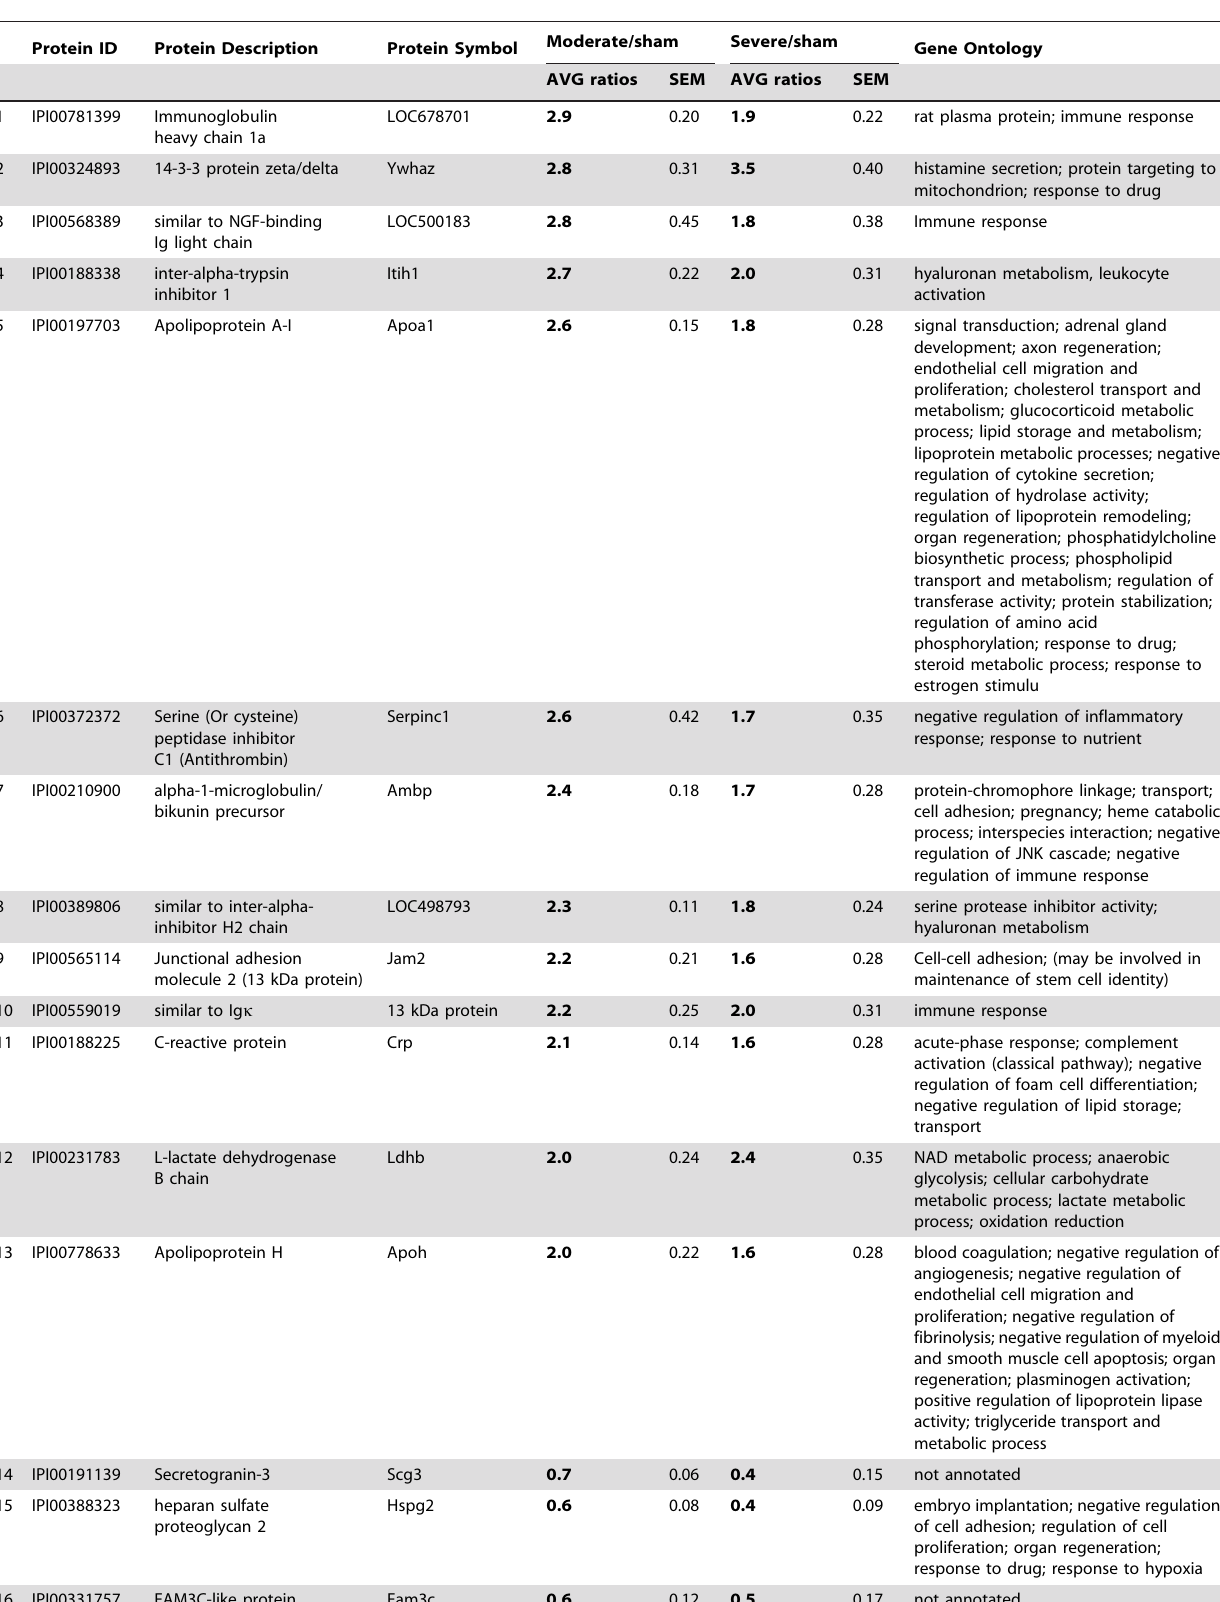
Table 1. Potential biomarkers of SCI identified by quantitative LC-MS/MS analysis of CSF from rats following experimental SCI.